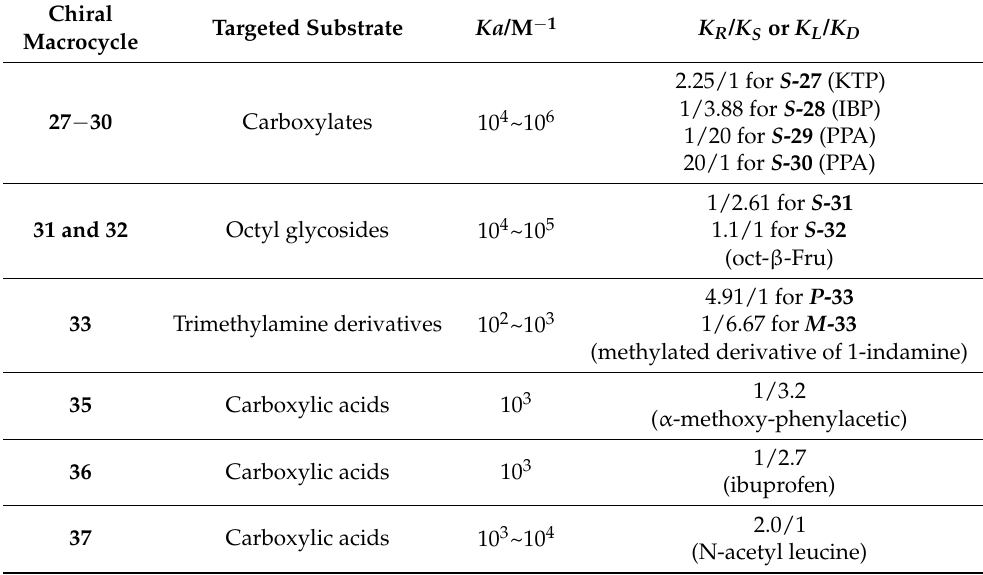
Table 2. The targeted substrates, binding constants (K a ), and highest ratios of enantiodifferentiation obtained with chiral macrocyclic chiral